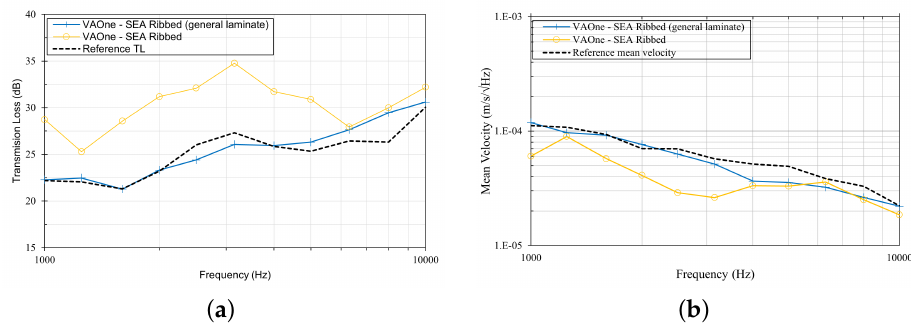
Figure 24. Vibro-acoustic responses of the equivalent SEA Ribbed model (TL optimisation): ( a ) sound transmission loss and ( b ) space-average mean vibration velocity.